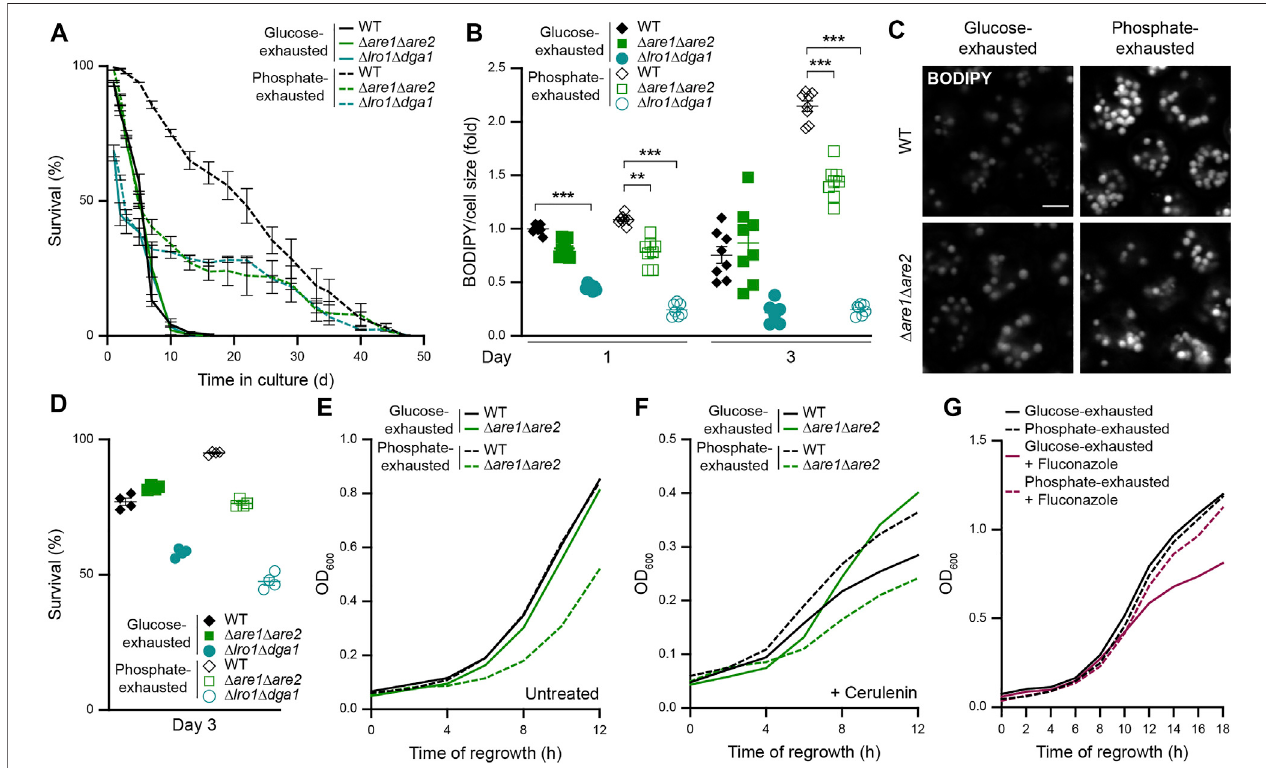
FIGURE 6 | Sterol ester biogenesis is critical for survival upon phosphate but not glucose exhaustion (A) Survival of WT (BY4742), Δ are1 Δ are2 and Δ lro1 Δ dga1 cells during chronological aging, determined via fl ow cytometric quanti fi cation of propidium iodide staining at indicated time points after glucose or phosphate exhaustion. Mean ± SEM; n = 4 (B) Flow cytometric quanti fi cation of neutral lipid content via BODIPY in cells described in (A). BODIPY mean fl uorescence intensity was normalizedtocellsizeanddataisshownasfoldofglucose-exhaustedWTcellsatday1;n=7 – 8 (C) ConfocalmicrographsofBODIPY-stainedWTand Δ are1 Δ are2 cells upon glucose or phosphate exhaustion at day 3. Scale bar: 2 μ m (D) Survival of cells described in (A) after 3 days of glucose or phosphate exhaustion, determined via fl ow cytometric quanti fi cation of propidium iodide staining; Mean ± SEM; n = 4 (E,F) Regrowth of WT and Δ are1 Δ are2 cells after 3 days of glucose or phosphate exhaustion.Nutrient-exhaustedcellswerere-inoculatedinunrestricted,freshstandardmediumandOD 600 wasmonitoredevery2 h.Cellswereleftuntreated(E)orwere treated with 1 µM cerulenin at the time point of re-inoculation (F); n = 8 (G) Regrowth of WT cells after 3 days of glucose or phosphate exhaustion. Nutrient-exhausted cells were re-inoculated in unrestricted, fresh standard medium and OD 600 was monitored every 2 h. Where indicated, cells were treated with 100 μ g/ml fl uconazole at the time point of re-inoculation to inhibit de novo sterol biosynthesis; n = 6. For more details in respect to statistical analyses, please see Supplementary Table S4 .